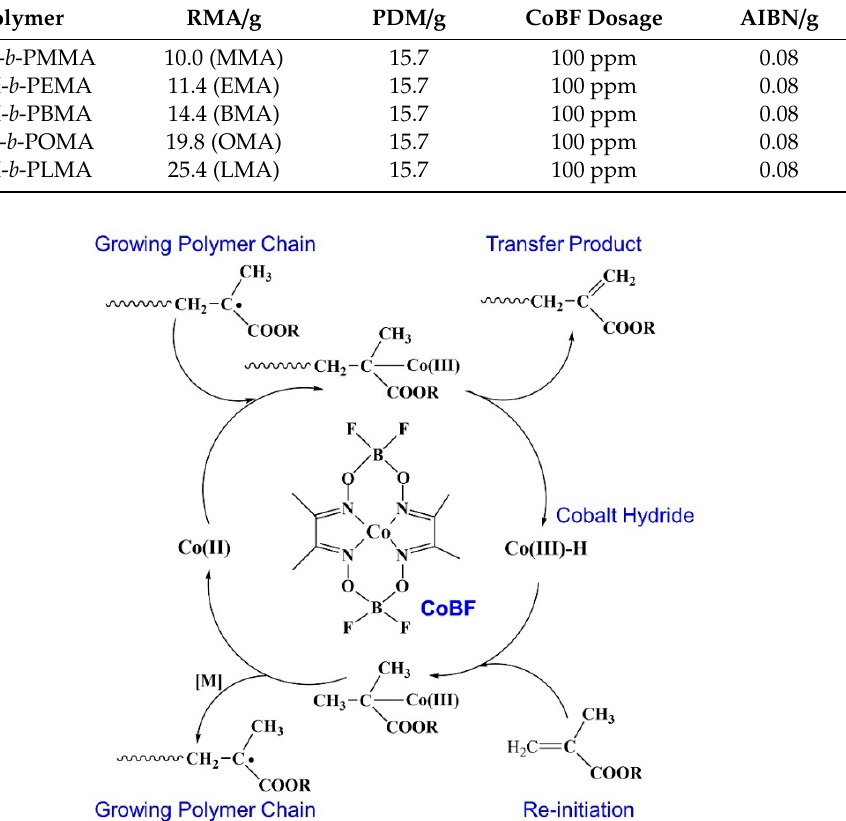
Table 1. Chemical compositions of PDM- b -PRM with different hydrophobic chain lengths. Polymer